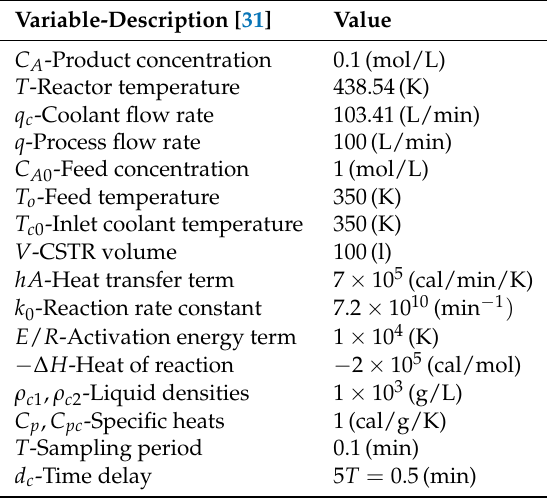
Table 1. CSTR variables